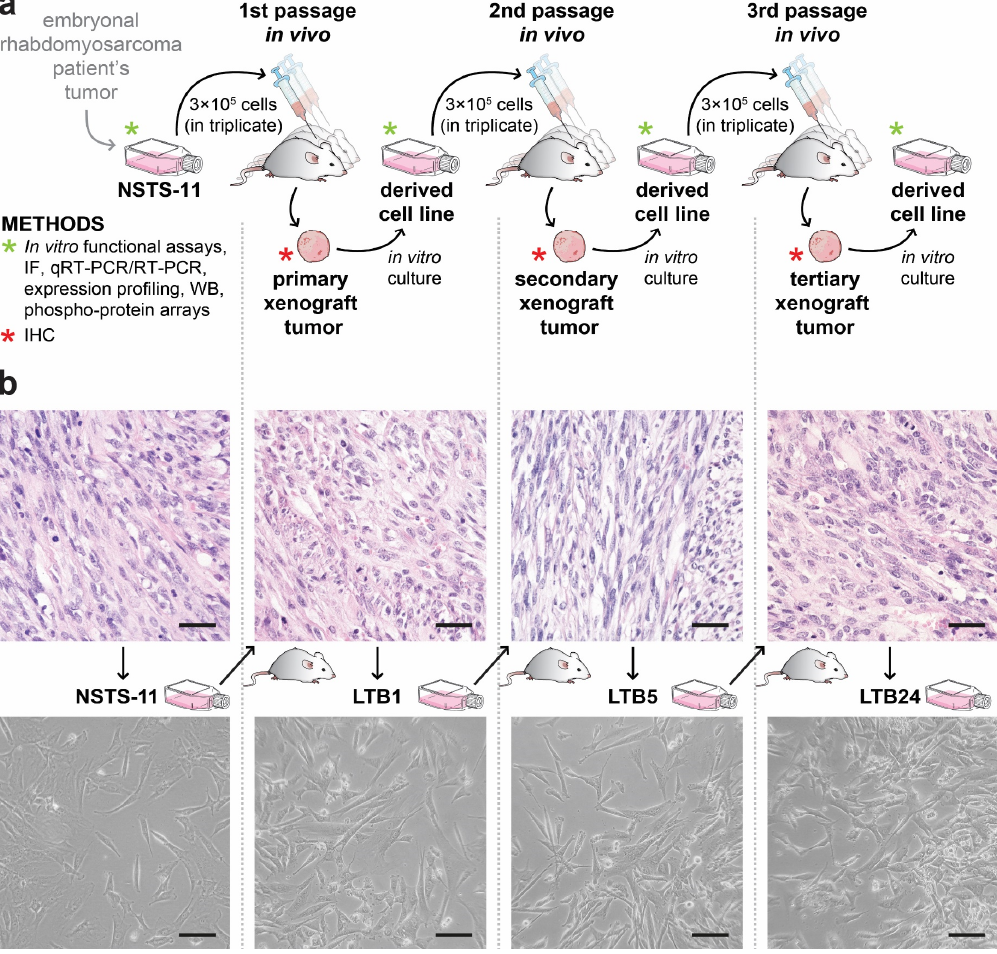
Figure 1. ( a ) Schematic overview of the experimental design. NSTS-11 cells derived from the embryonal rhabdomyosarcoma were injected subcutaneously into three NOD/SCID gamma (NSG) mice (in vivo passage). After the appearance of a tumor, the mouse was sacrificed, and the xenograft tumor was excised and divided into equal parts. One part of the xenograft tumor was used to prepare formalin-fixed paraffin-embedded (FFPE) tissue sections. The second part was processed for primary culture, and the derived cell line was used in a subsequent passage in vivo. This procedure was